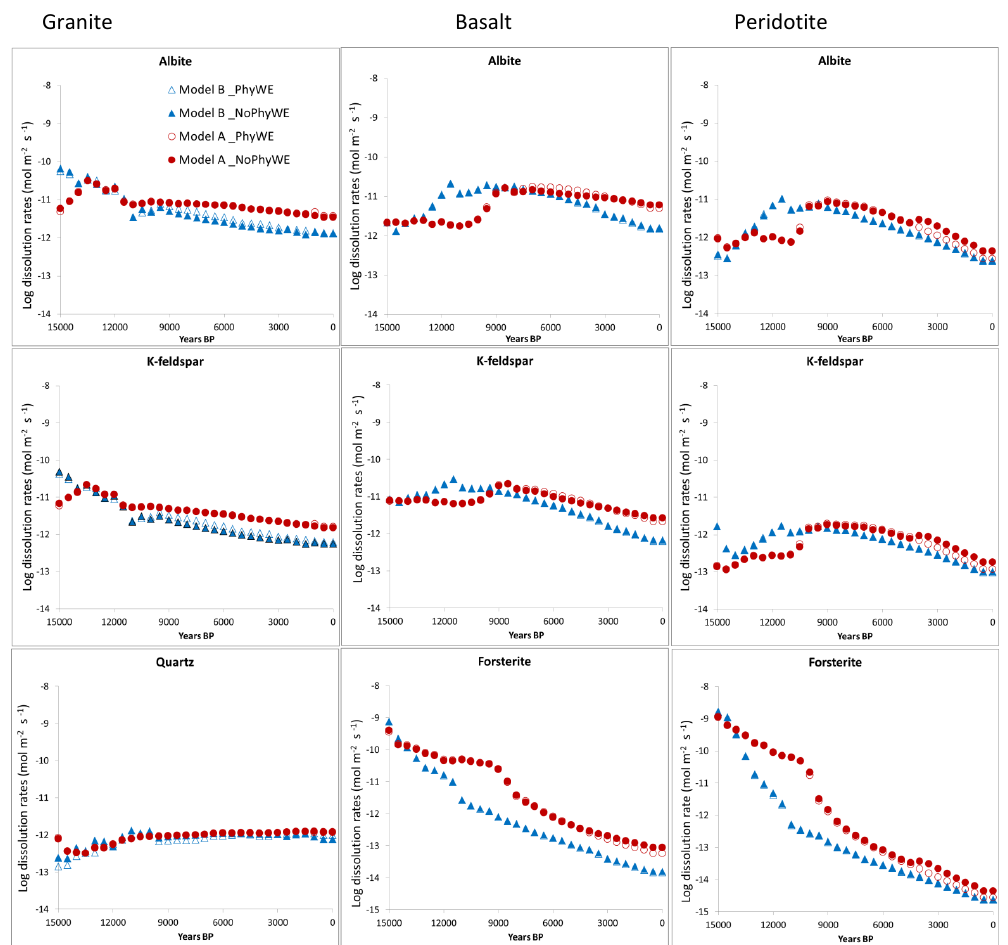
Figure 4. Example (based on soil texture number 5; Table 1) of time evolution of silicate dissolution rates in different parent materials (Granite, Basalt and Peridotite). The modelled rates are calculated for a depth of 0.5m for every 500years. Model A: Circles; solid (no physical weathering) open (physical weathering allowed). Model B: Triangles; solid (no physical weathering) open (physical weathering